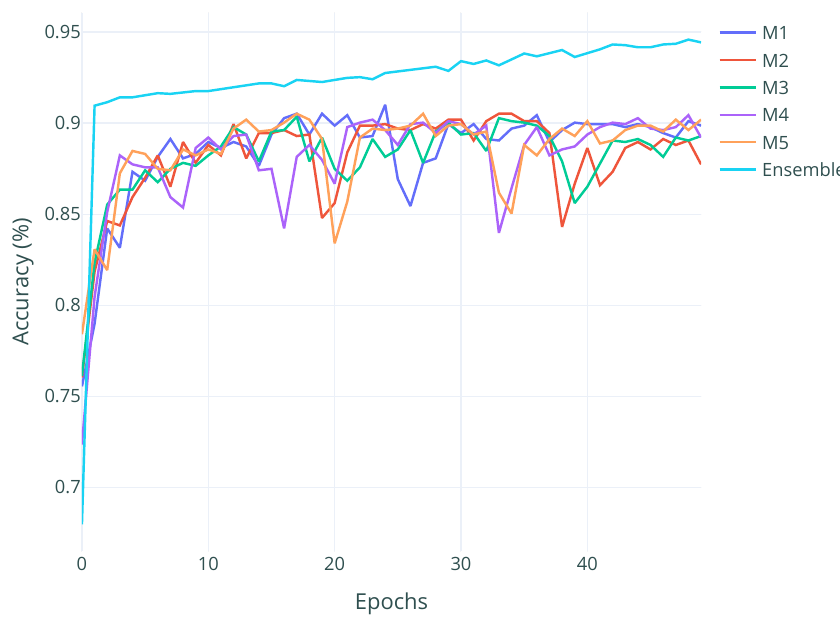
Figure 2. Epochs vs. loss graphs.